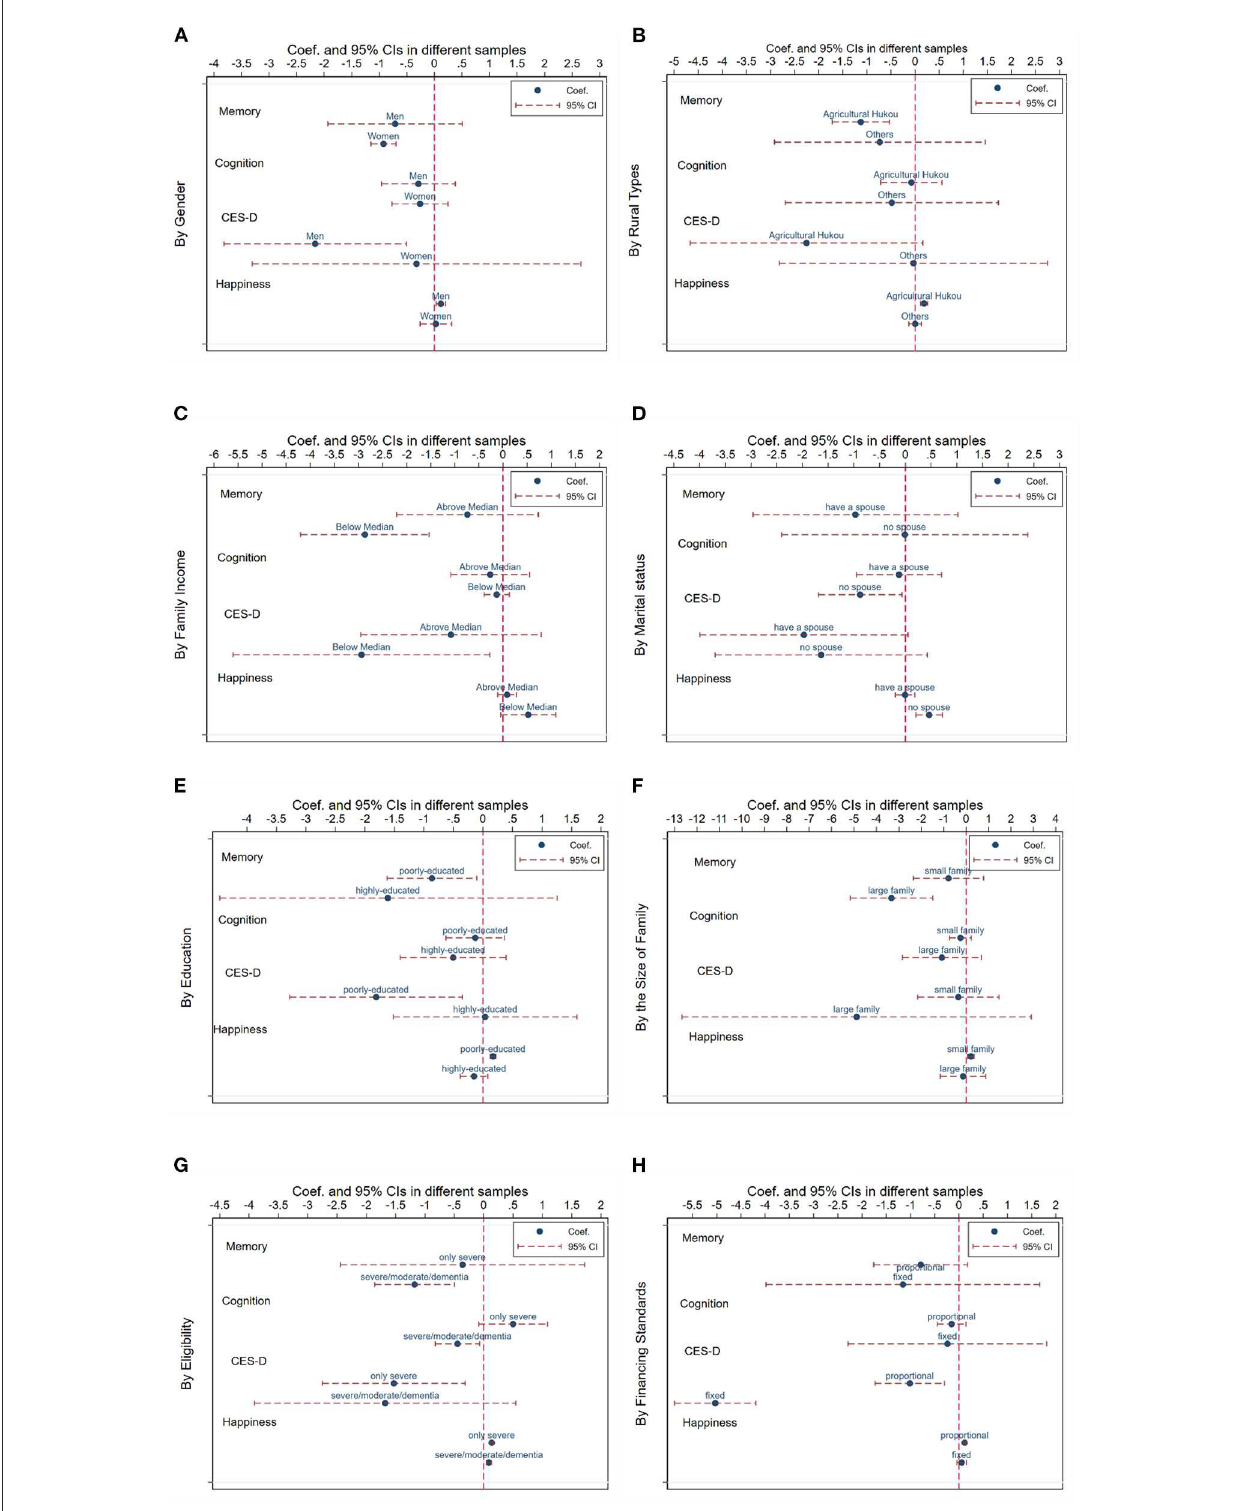
FIGURE5 Heterogeneous impacts of LTCI. (A) Gender. (B) Rural types. (C) Family income. (D) Marital status. (E) Education. (F) Family size. (G) Eligibility. (H) Financing